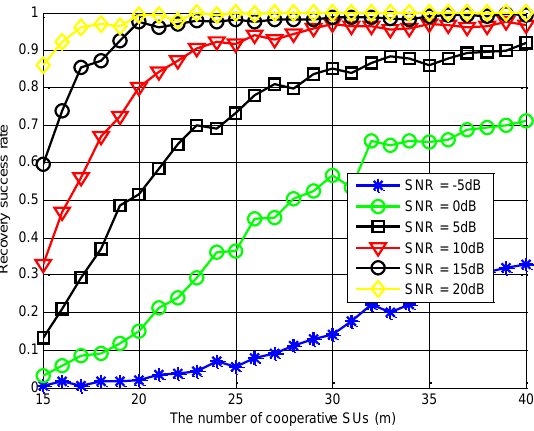
Figure 11. Performance comparison of the PSS-SaDMWC scheme under different SNR levels.